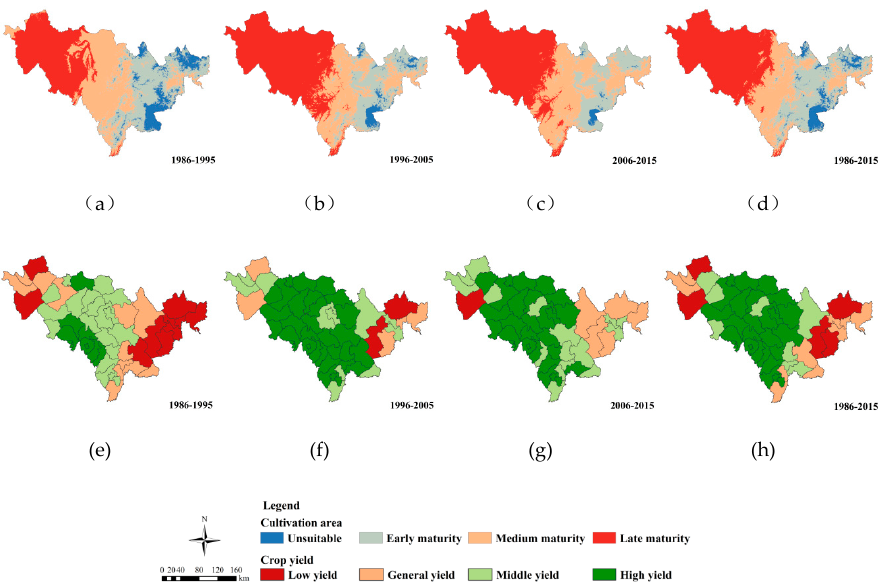
Figure 3. Spatial distribution of cultivation patterns ( a – d ) and yield ( e – h ).